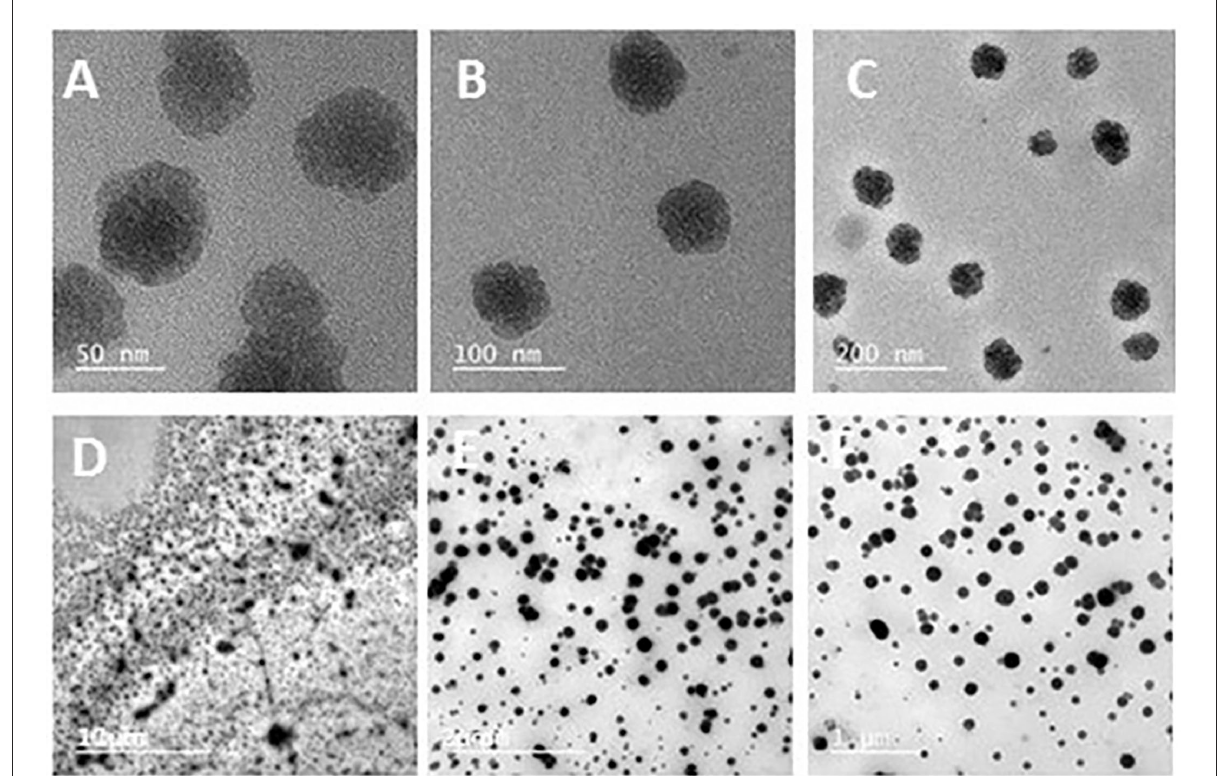
FIGURE2 Transmission electron microscopy of chitosan nanoparticles showing spherical shapes with uneven borders and uniformity, with average diameters ranging from 50 to 200nm (A–C) , as well as a propolis–chitosan mixture (D–F)